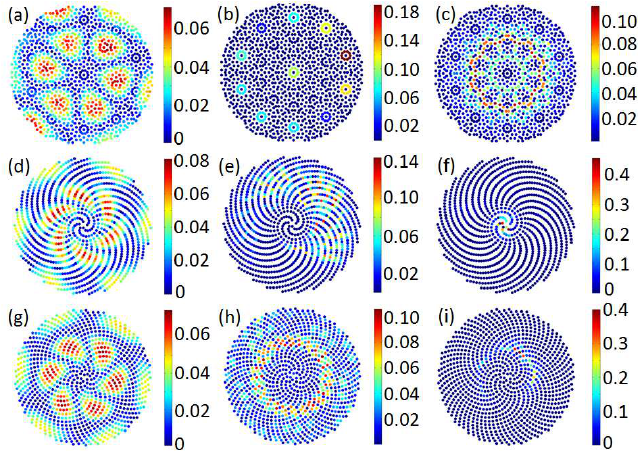
Figure 6. Representative eigenvectors of the edge-length weighted graph Laplacian matrix for different aperiodic structures. ( a – c ) for an N = 1108 Penrose array with (eigenvalues equal to 0.3398, 5.4721, 8.2152, respectively); ( d – f ) for a µ -spiral array (eigenvalues equal to 1.2338, 20.0862 and 21.6709, respectively); ( g – i ) for a τ -spiral array (eigenvalues equal to 0.7915, 4.8394 and